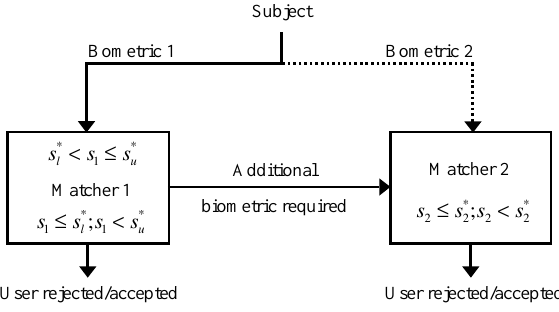
Figure 1. The outline of multimodal biometric system in serial fusion